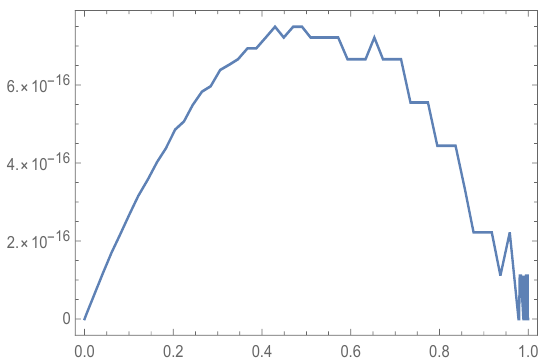
Figure 4. MAE of Z N ( x ) of our algorithm at υ 1 = 0.7 and b = 1 with N = 2 for Example